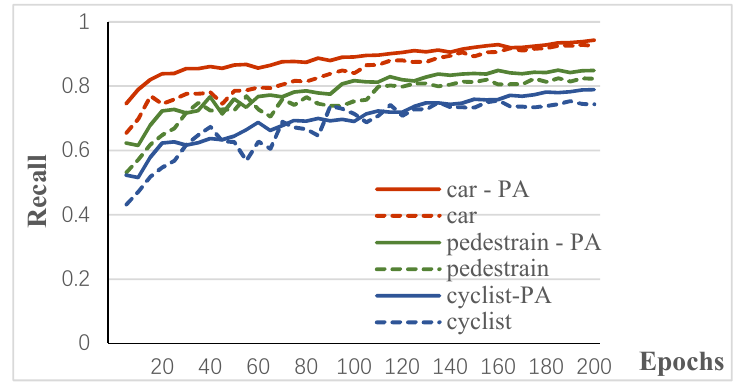
Figure 10. Recall curves of embedding attention modules in part-1 for the three classes. The solid lines refer to embedding PA, and the dotted lines refer to no-attention.